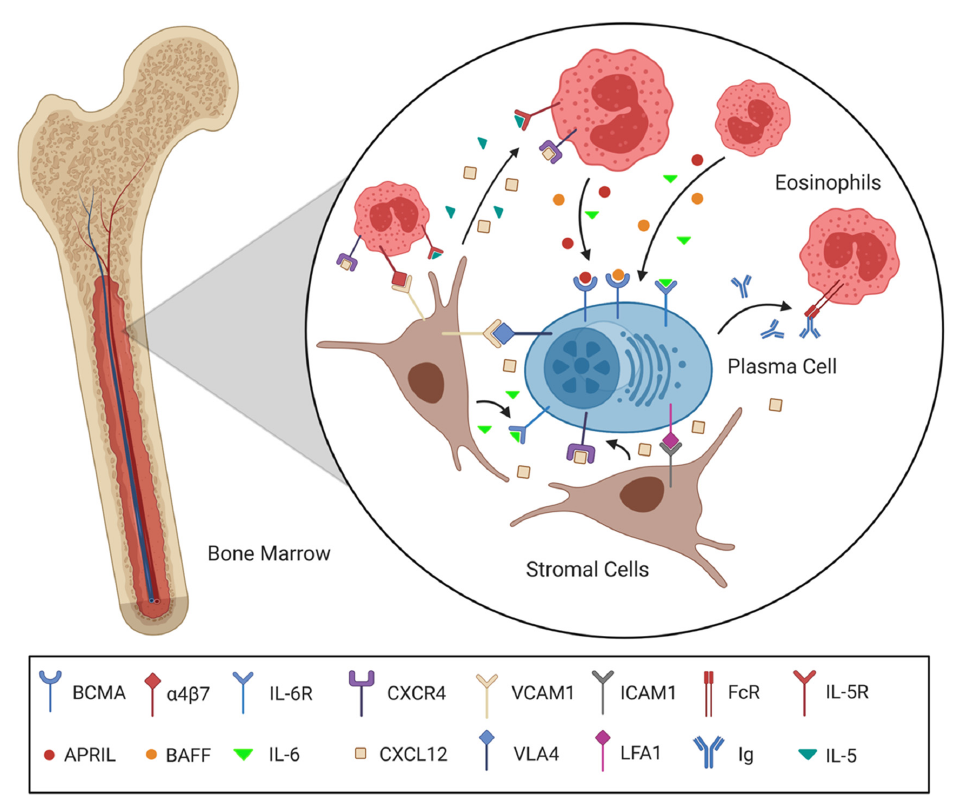
Figure 2. The system of support between plasma cells, stromal cells and eosinophils in a BM survival niche. Following a CXCL12 gradient secreted by stromal cells, a plasma cell migrates into the BM and settles into a free survival niche. Integrin interactions such as VCAM1-VLA4 and ICAM1-LFA1 not only maintain positioning but also promote survival. Eosinophils co-localize with the plasma cell by means of the CXCL12-CXCR4 axis and VCAM1 binding α 4 β 7. The Eosinophils are subsequently induced to produce plasma cell survival stimulating IL-6 and APRIL via IL-5R, α 4 β 7 and FcR engagement. In contrast to the plasma cell, eosinophils are continuously proliferating and replaced due to their short lifespan. The support between the cells involved is delicately balanced to enable a static-and-dynamic survival niche for the maintenance of the plasma cell. (Created with